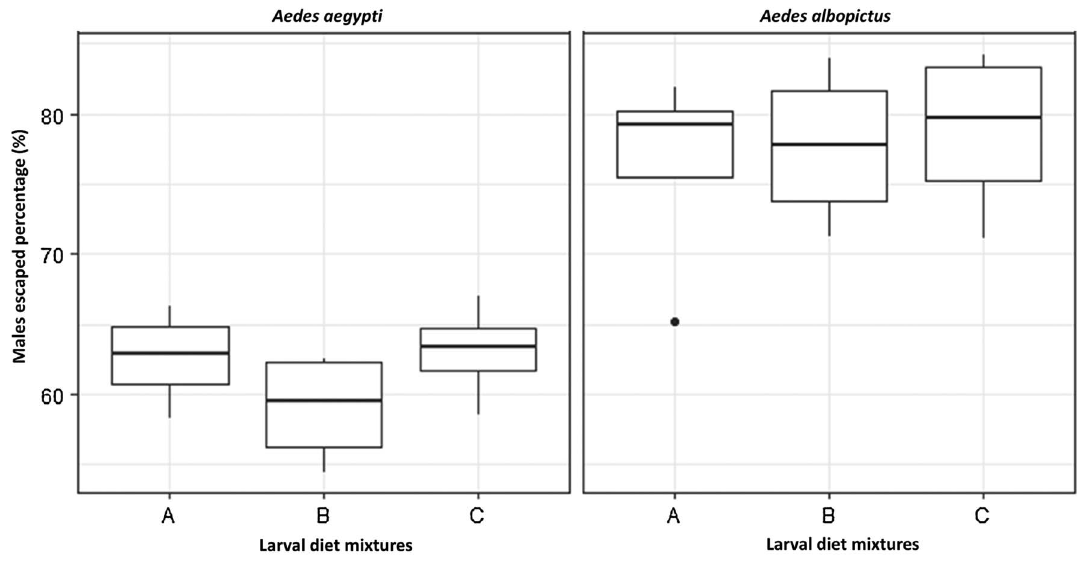
Figure 2. Flight ability of male Aedes aegypti and Aedes albopictus. Diet A = 50% TM + 35% BLP + 15% BY, Diet B = 50% TM + 35% BSF + 15% BY, Diet C = 50% TM + 50% BSF.